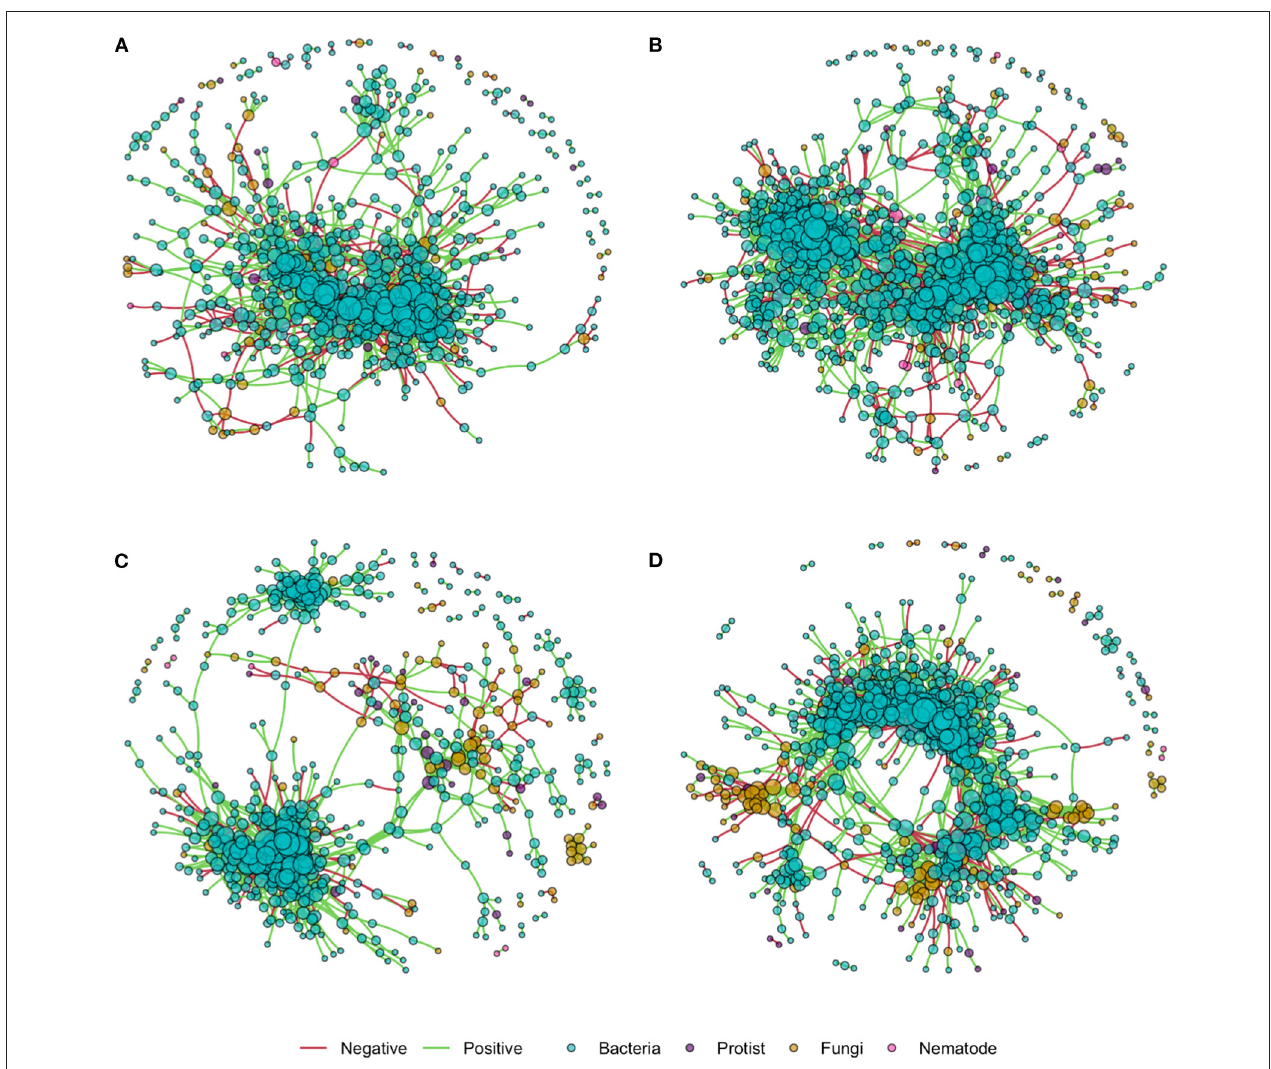
FIGURE 3 | Inter-kingdom microbial correlation networks in the rhizosphere and soil of oilseed rape in high and low nitrogen treatments, using data from 10 oilseed rape genotypes for each nitrogen treatment. Edges indicate correlation of > 0.8 or < -0.8. (A) Rhizosphere high N; (B) Rhizosphere low N; (C) Soil high N; (D) Soil low